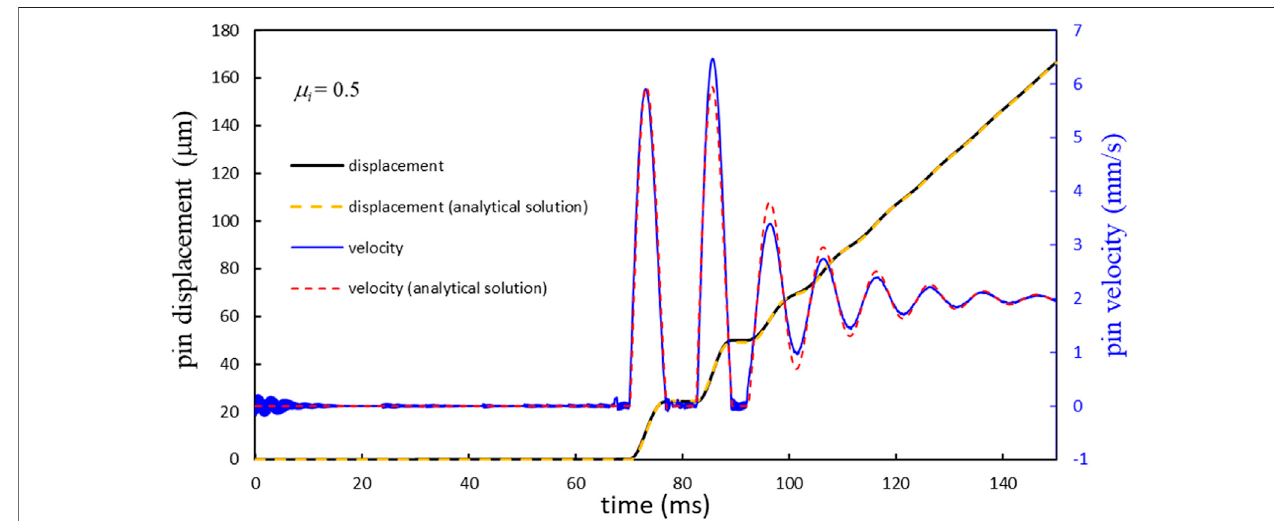
FIGURE 10 | Motion of the pin during dynamic simulation.